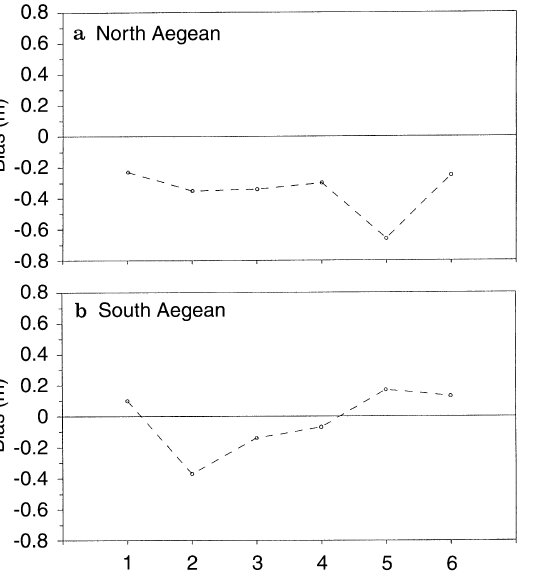
Fig. 9a,b. Bias of compared wave-height results with different wind source (UKMO v. ECMWF). a North Aegean; b South Aegean